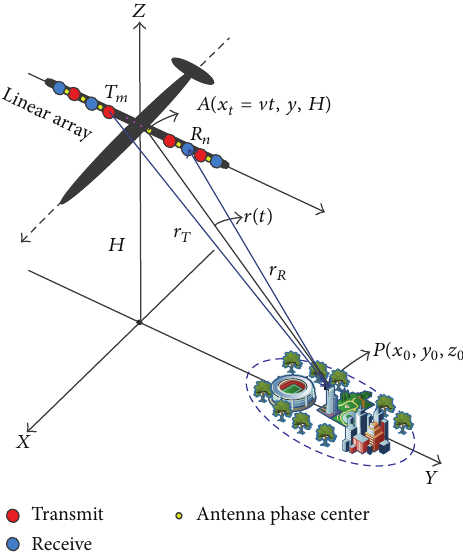
Figure 1: The ideal geometry of MIMO SAR 3D imaging.